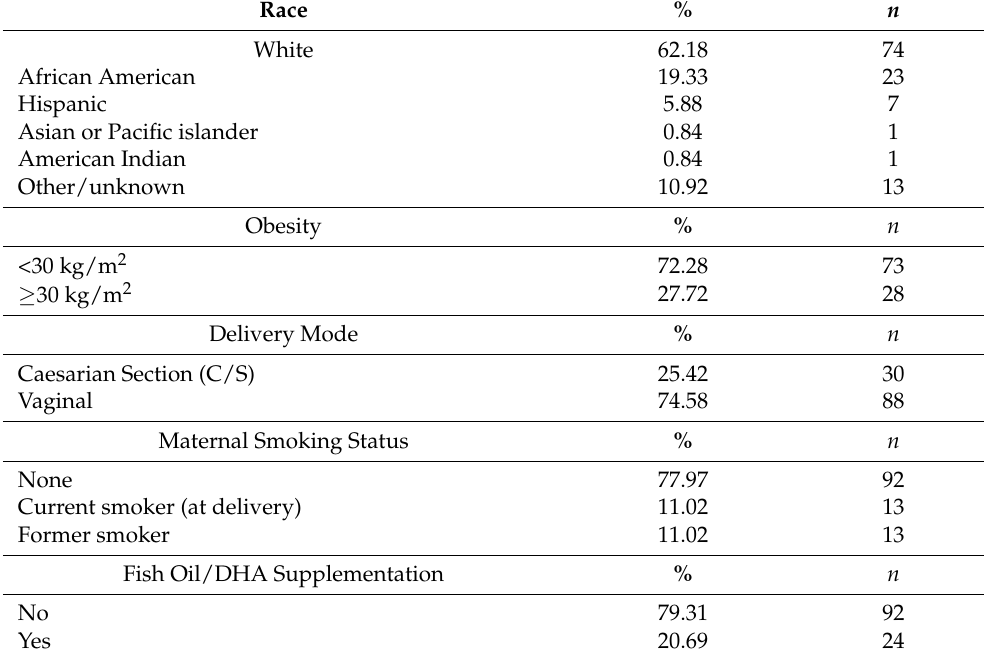
Table 2. Maternal